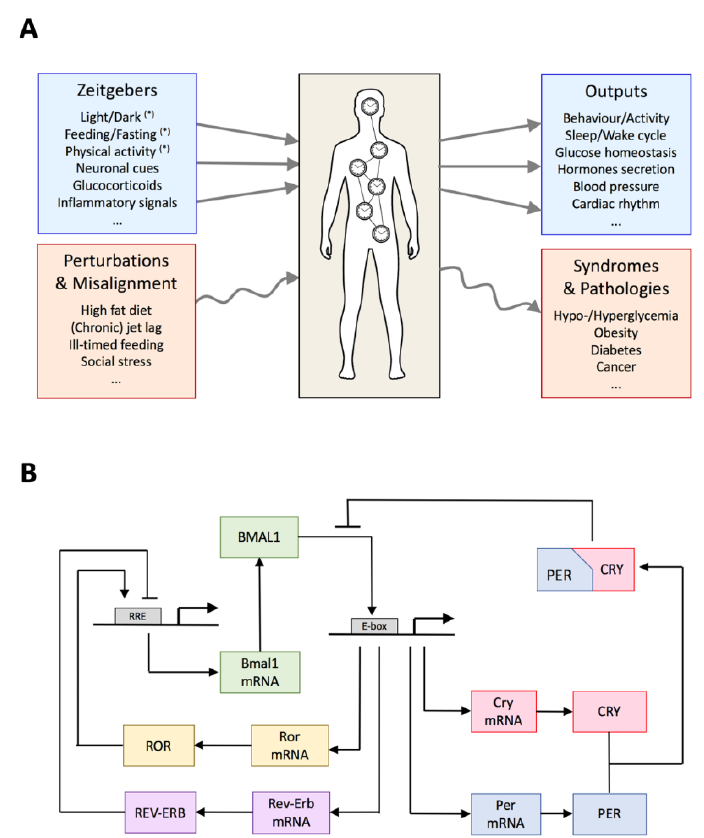
Figure 1. ( A ) The circadian system consists of a network of coupled clocks, receives multiple inputs (zeitgebers), and controls many aspects of physiology and metabolism. Alteration of the zeitgebers (e.g., via circadian misalignment or jet lag) can lead to metabolic syndromes and pathologies. Of note, central and peripheral clocks differ by the nature and/or sensitivity of the different zeitgebers. We can also distinguish external zeitgebers (such as light and food, denoted by an asterisk) and internal zeitgebers (hormones and neural projections involved in the internal coupling between the clocks). ( B ) Scheme of the genetic regulatory network underlying circadian gene expression. The scheme focuses on the core genes/proteins which are circadianly expressed. Clock, which is constitutively expressed, is not